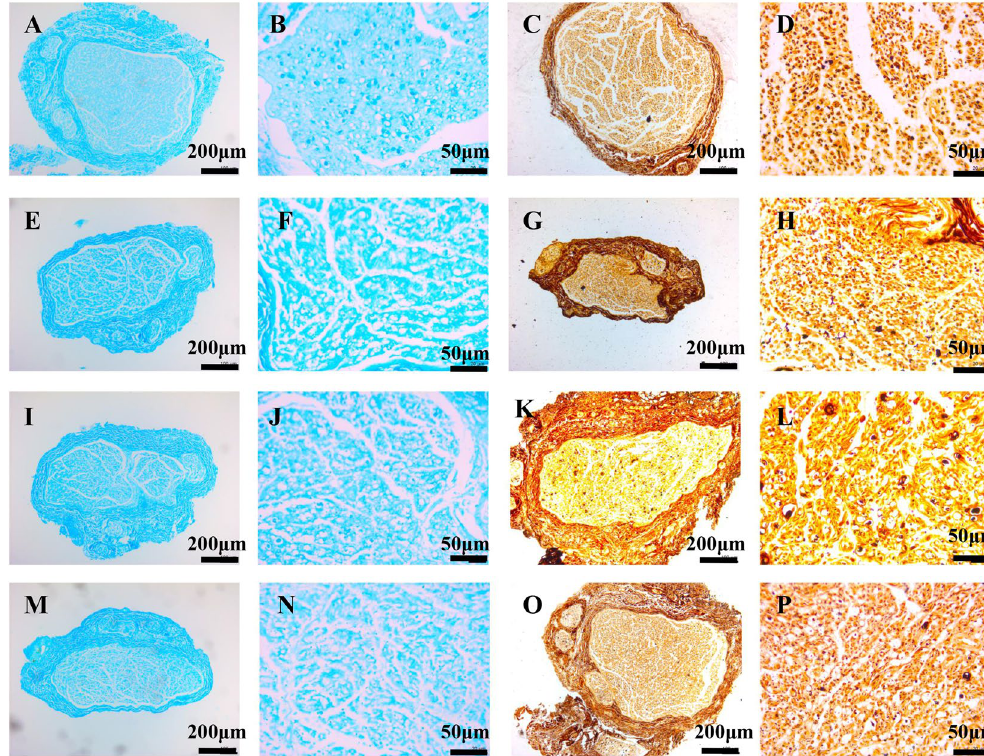
Figure 1. Histopathological examination of injured facial nerves on day 7 by Luxol fast bule staining ( A,B,E,F,I,J,M,N ) and Bielschowsky staining ( C,D,G,H,K,L,O,P ). Grade I injured facial nerve (A-D) had an integrated perineurium and continuous axons with well-distributed and aligned myelin sheaths in the cross- sections. Grade II injured facial nerve ( E–H ) had patchy loss of myelin sheaths with intact nerve bundles.